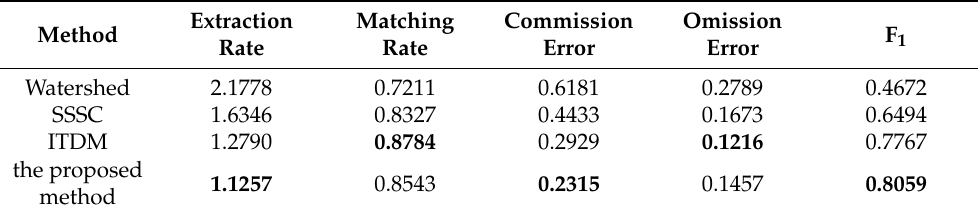
Table 4. Comparison of average accuracy of the four methods. The bold represents the best value among the comparison